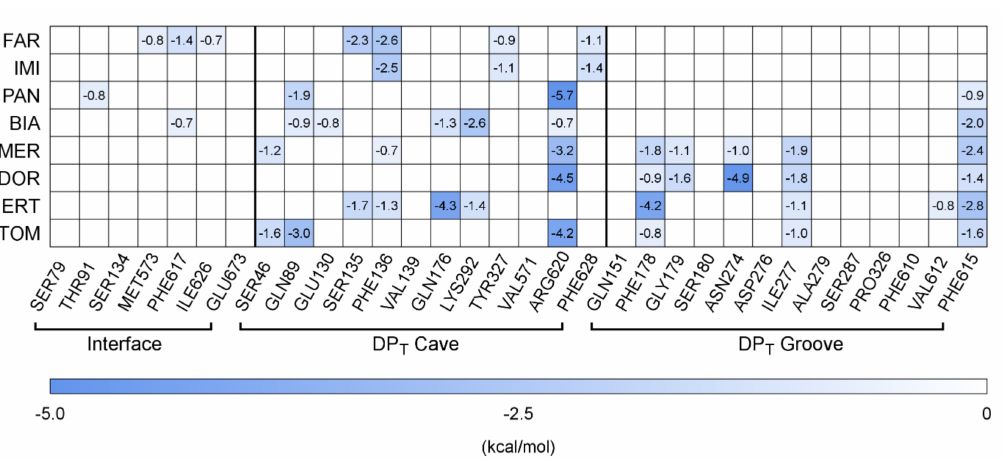
Figure 4. Per-residue contributions to the free-energy of binding (kcal / mol) of carbapenems to AcrB. See Figure 3 for further